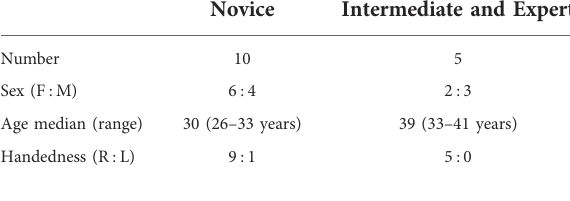
TABLE 1 Participant demographics. Novice Intermediate and